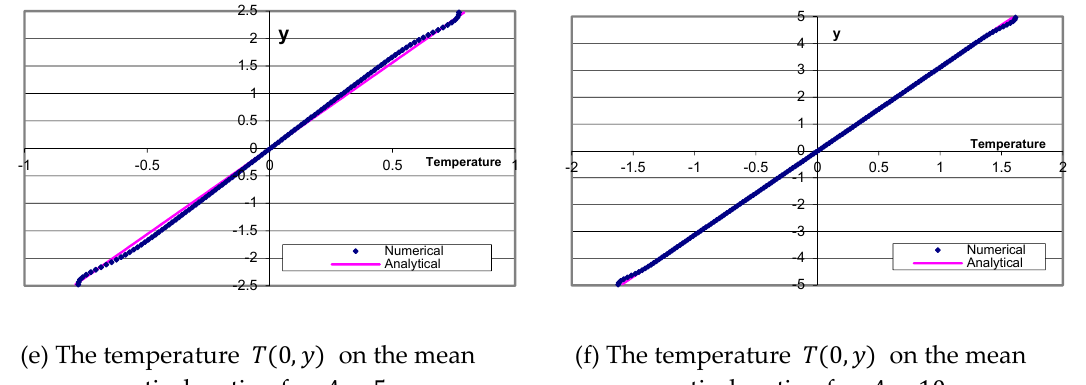
Figure 6. The velocity v ( x ) on the mean horizontal section ( a ) for A = 5 and ( b ) for A = 10; the temperature Θ ( x ) on the mean horizontal section ( c ) for A = 5 and ( d ) for A = 10; the temperature T ( 0, y ) on the mean vertical section ( e ) for A = 5 and ( f ) for A = 10. From the comparison between Figure 6e,f, it may be highlighted that the analytical and numerical solutions have a similar trend, except for the two tails. In these zones, the two solutions di ff er because of the adiabatic walls; actually, the condition of adiabatic horizontal walls does not a ff ect the analytical solution, while they are considered in the numerical simulations. Finally, the comparison of the temperature field (cid:1846)((cid:1876), (cid:1877)) for the two solutions with (cid:1827) = 5 and reported in Figure 7.